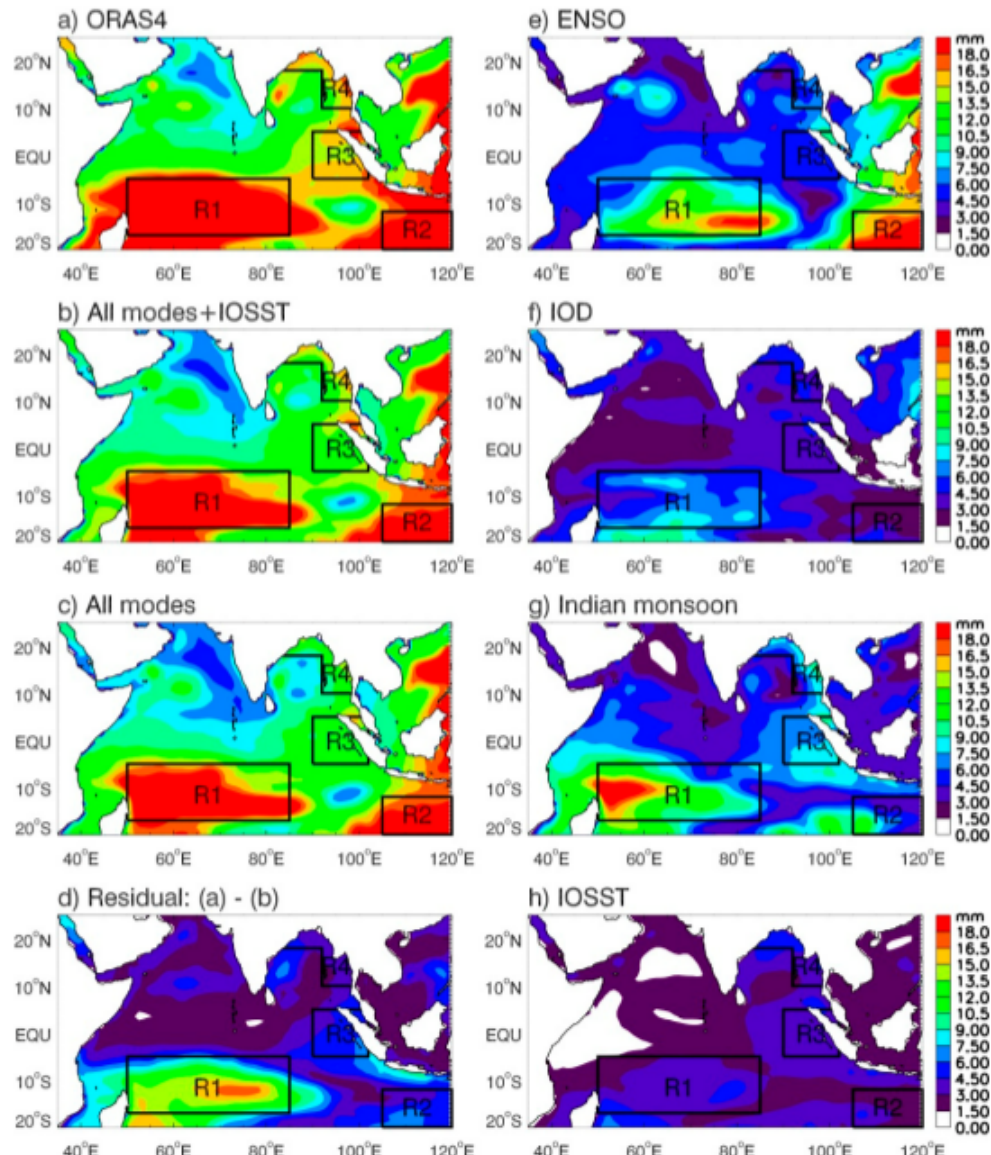
Figure 6. ( a ) The standard deviation map of ORAS4 8 year low-passed SLA for the 1962–2011 period based on the yearly mean (all 12 months) sea level data; it is the same as Figure 4a except for adding boxed region R3 in the eastern equatorial basin (90 ◦ E–102 ◦ E, 5 ◦ S–5 ◦ N) and boxed region R4 in the Bay of Bengal coast. R4 consists of an area east of 92 ◦ E but north of 10 ◦ N and an area west of 92 ◦ E but north of 18 ◦ N; ( b ) same as ( a ) but for SLA associated with all climate modes (ENSO + IOD + monsoon) plus the effect of IOSST, which to some extent represents external forcing; ( c ) same as ( b ) but only for climate modes (ENSO + IOD + monsoon), and it equals the IOSST effect subtracted from panel ( b ); ( d ) same as ( b ) but for the residual, difference for ( a , b ), measuring the effects that cannot be explained by the climate modes and IOSST; ( e – h ) are the same as ( b ) but for the individual effect of decadal ENSO, IOD, monsoon, and IOSST. Units: mm. The boxed regions have large variances and are used to calculate the time series